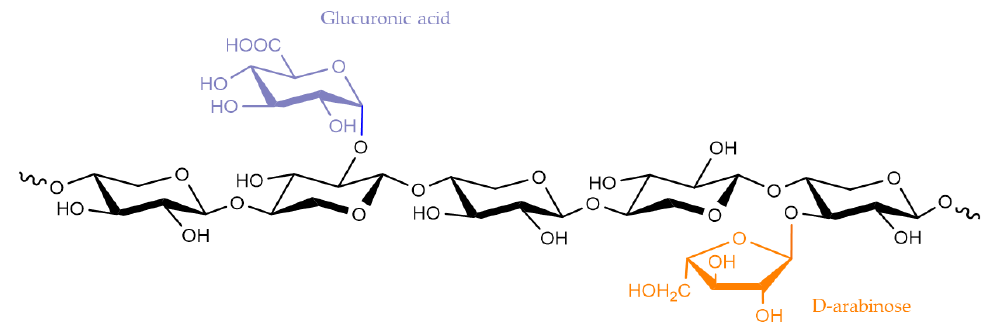
Figure 6. Chemical structure of xylan hemicellulose.